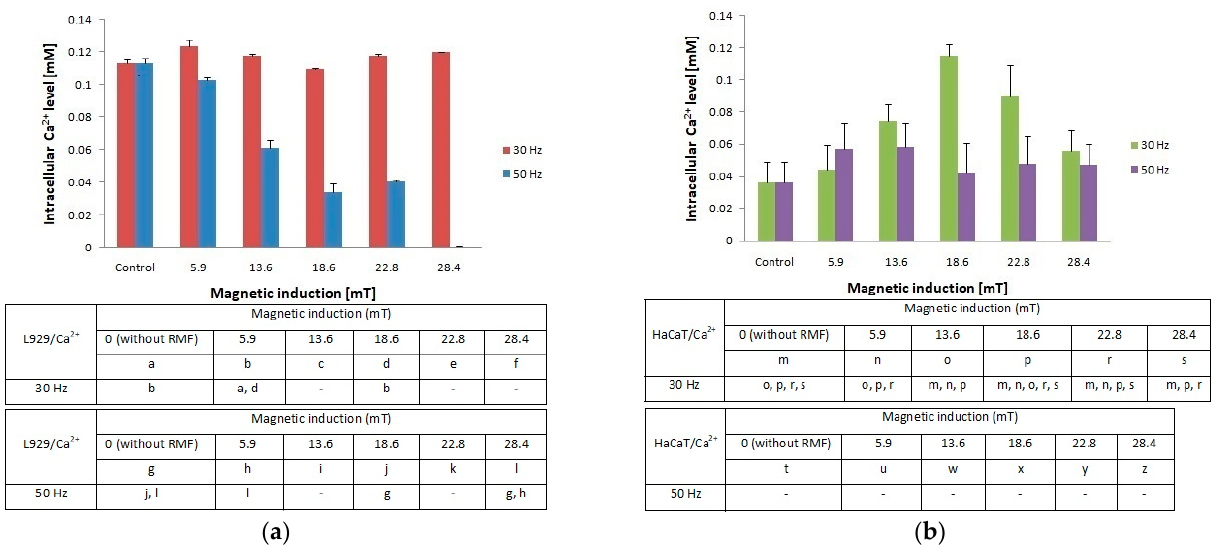
Figure 4. Intracellular Ca 2+ level in L929 ( a ) and HaCaT ( b ) cell cultures after 4-h exposition to different magnetic induction and frequency of RMF (all samples were compared to control; p -values < 0.05 were considered significant and were represented by small letters).